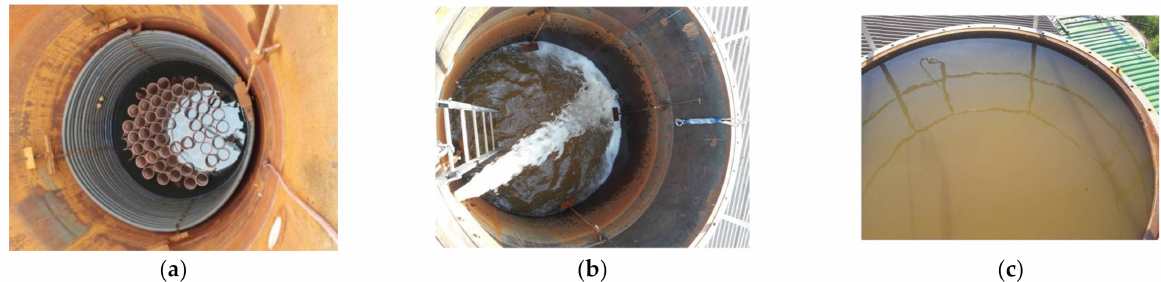
Figure 6. Example of fermenter tightness test-view: ( a ) adhesive skeleton bed; ( b ) mixing system in the reactor-pressing the inert medium; ( c ) fermenter flooded with the maximum inert factor (photo by Grzegorz